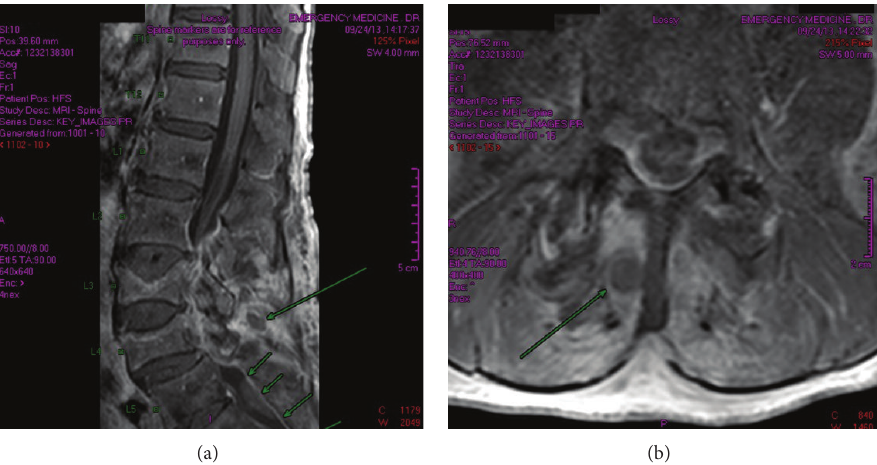
Figure 3: T1 weighted images postgadolinium sagittal and axial views: enhancement and oedema shown in the posterior ligamentous